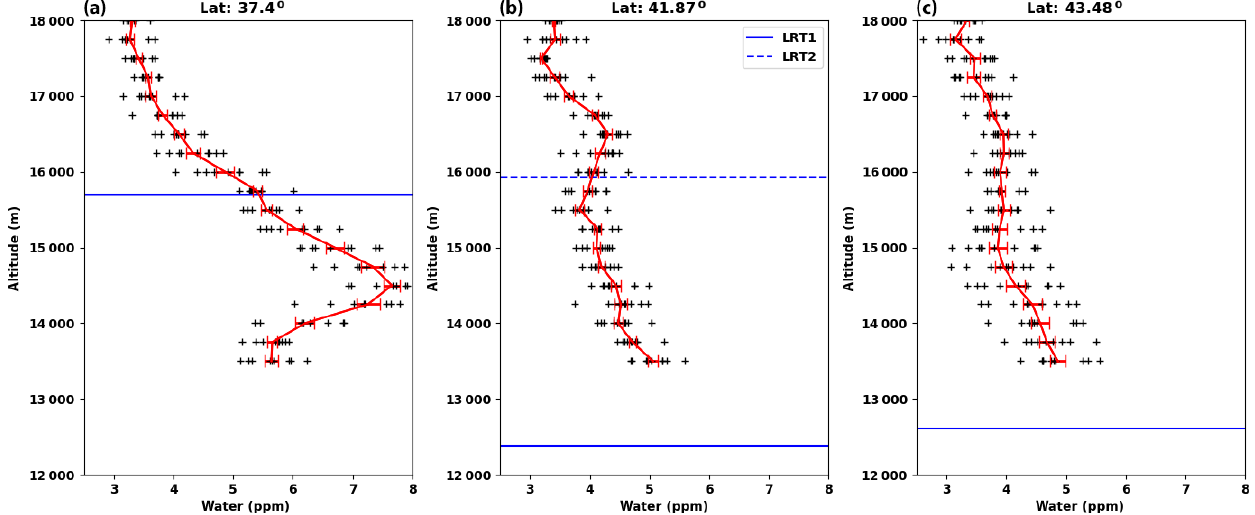
Figure 5. Example SHOW profiles at 37.4 (a) , 41.87 ◦ N (b) , and 43.48 (c) . All profiles lie closely along the 124.5 ◦ W longitude line. The black data points correspond to each of the individual profiles, and the red line is the average of all latitude measurements in each altitude bin. The error bars show the precision of the averaged measurements. The first and second tropopause are identified as the solid blue and dotted blue lines